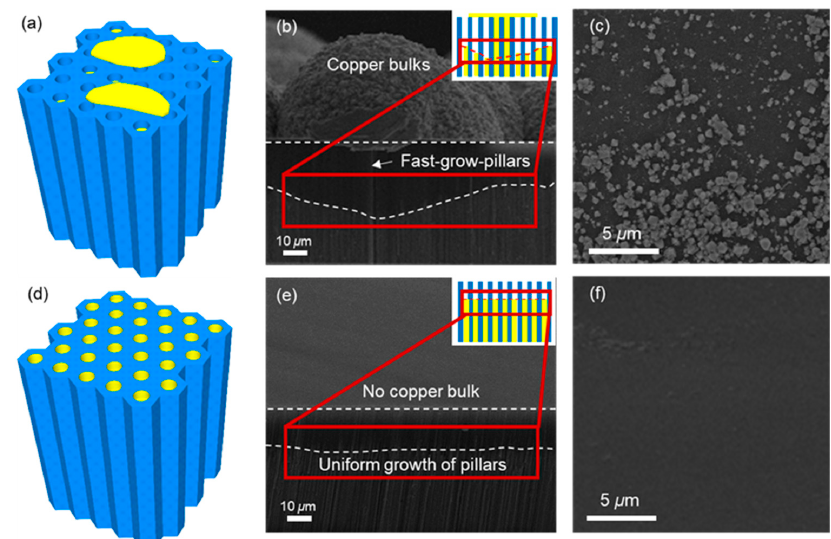
Figure 4. ( a ) The schematic depiction of nano-pillars electrodeposition at high current density; ( b ) SEM images of side-view at high current density; ( c ) top-view of SEM images at high current density; ( d ) the schematic of nano-pillars electrodeposition with low current density; ( e ) side-view of SEM images at low current density; ( f ) top-view of SEM images top-view at low current density. To investigate the effect of temperature on the nano-pillar growth behavior, the current density is fixed at 10 A/dm 2 . Figure 5 shows the AAO film surfaces after electrodeposition process under different deposition temperatures (20 °C, 40 °C, 60 °C). Figure 5a shows that a low pore-filling percentage of 40.2% was obtained at 20 °C. When the electrodeposition temperature increased up to 40 °C, more pores were filled, and the pore-filling reached 61.8%. Lastly, the pore-filling percentage reached up to 89.8% under 60 °C. The relationship between the pore-filling percentage and temperature is shown in Figure 5d. The pore-filling percentage increased with the electrodeposition temperature.